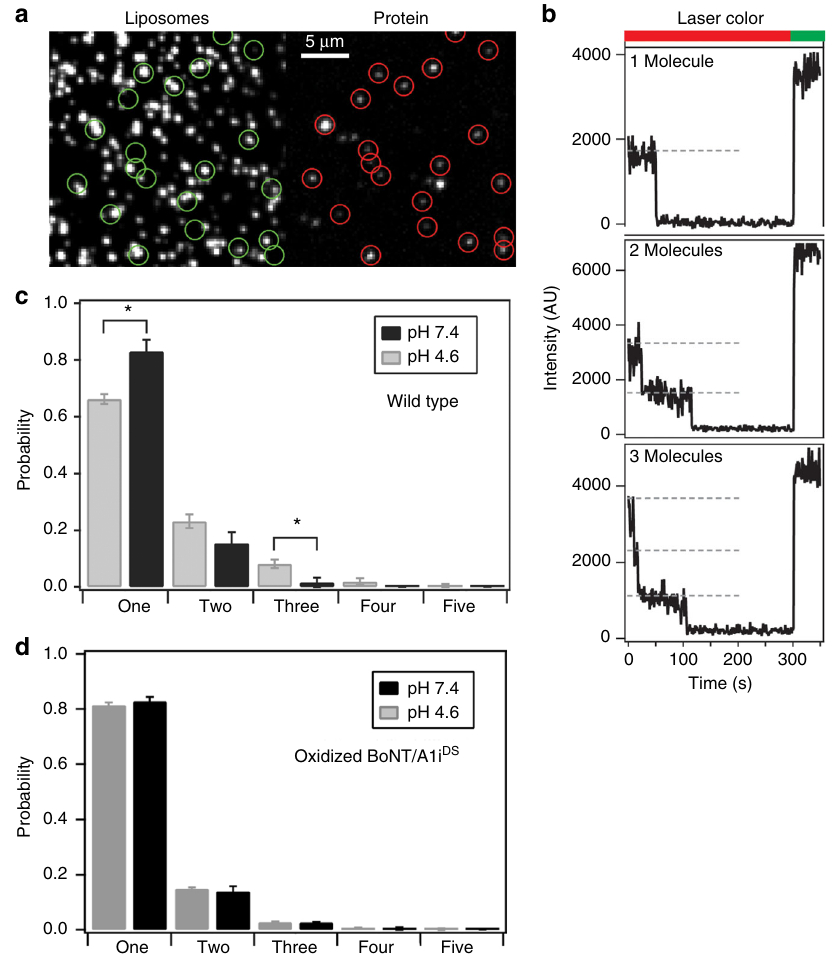
Fig. 4 Single-molecule analysis of the distribution of BoNT/A1i on individual liposomes. a Representative TIRF microscope images showing co-localization of Alexa 647-labeled BoNT/A1i-D12* complexes (right) with rhodamine-labeled liposomes (left). In these experiments, < 10% of liposomes were occupied by protein to minimize co-localization. The circled spots on the right were used for photobleaching analysis only when co-localized with rhodamine fl uorescence. b Representative time traces of fl uorescence emission from spots used to assess the oligomerization state. The bar above the panel indicates the excitation with red laser used to fi rst bleach the Alexa 647 followed by green laser to probe for rhodamine emission. Examples are shown for 1-, 2-, and 3-step photobleaching events. Dashed lines highlight individual bleaching steps. ( c ) Distribution of bleaching steps for BoNT/A1i-D12* at pH 4.6 ( n = 935) and pH 7.4 ( n = 482). The increase in 1-step events and decrease in 3-step events upon raising the pH to 7.4 were statistically signi fi cant (asterisk) with p = 0.0001 and 0.0065, respectively. The decrease in 2-step events was just above signi fi cance with p = 0.077. d Distribution of photobleaching steps for oxidized BoNT/A1i DS -D12* at pH 4.6 ( n = 589) and pH 7.4 ( n = 535). No signi fi cant differences were observed when the BoNT-switch was locked by a disul fi de bond. Error bars indicate standard error of measurement (SEM) from replicate